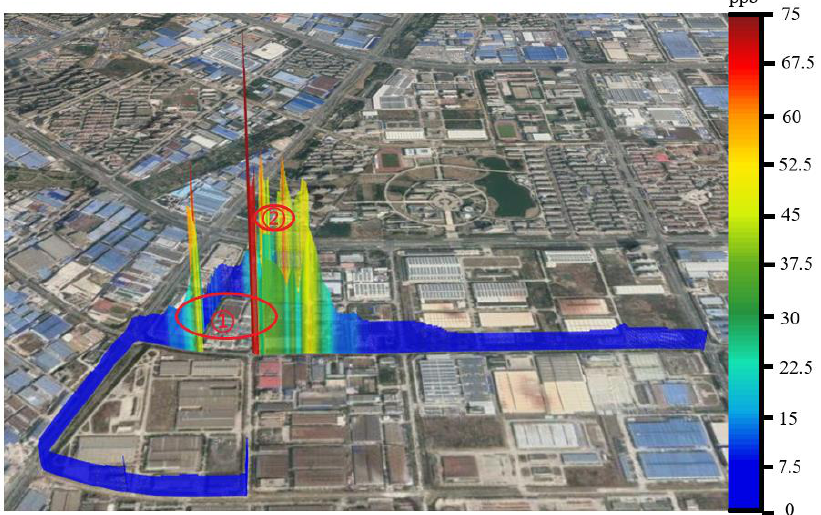
Figure 7. The concentration changes in toluene during the process of navigation detection. (The height of the cylinder represents the concentration of toluene; the color indicates the relative concentration.).